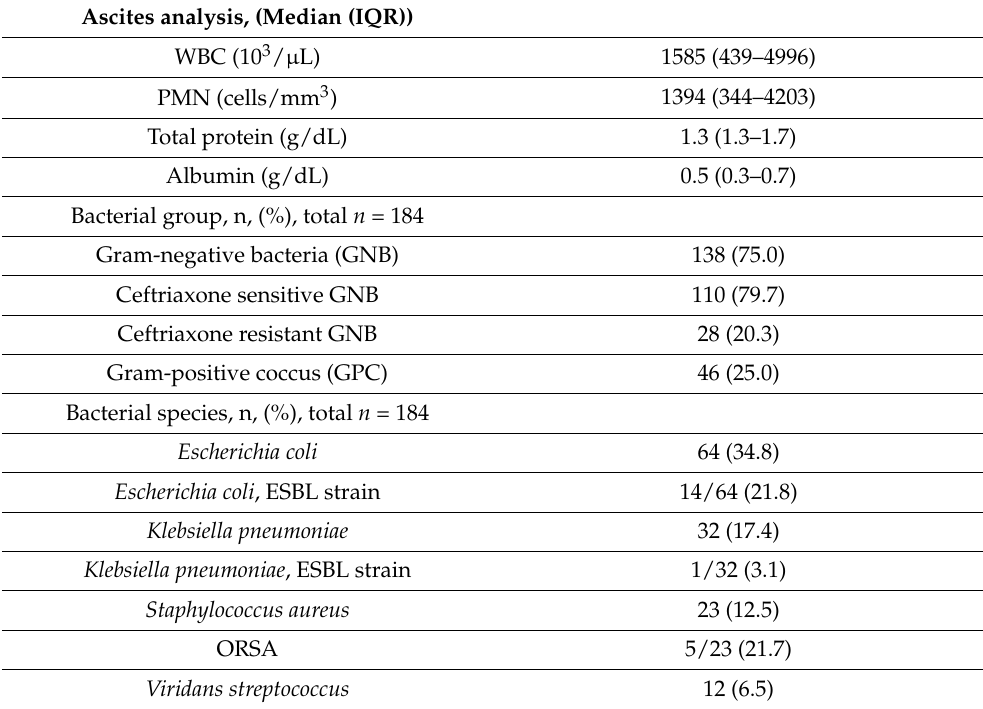
Table 3. Bacterial culture results of 327 patients with first SBP episode.